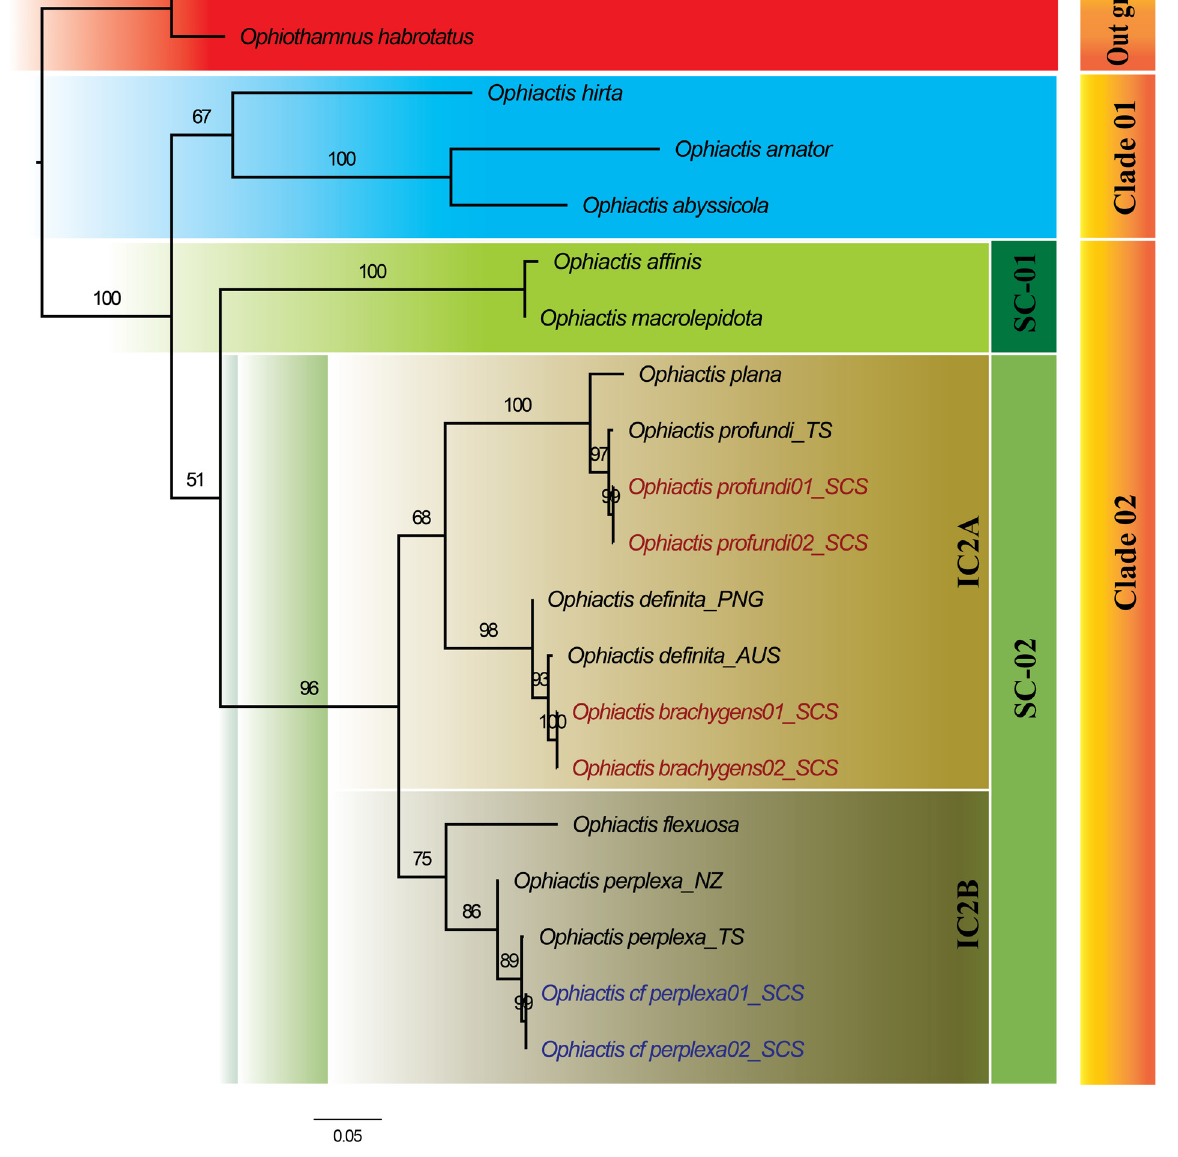
Fig. 48. Family Ophiactidae Matsumoto, 1915, Maximum likelihood (ML) tree based on partial COI sequences (bootstrap support values were generated with rapid bootstrapping algorithm for 1000 replicates). Abbreviations: AUS = Australia; IC = Inter-Clade; NZ = New Zealand; PNG = Papua New Guinea; SC = Sub-Clade; SCS = South China Sea; TS = Tasman